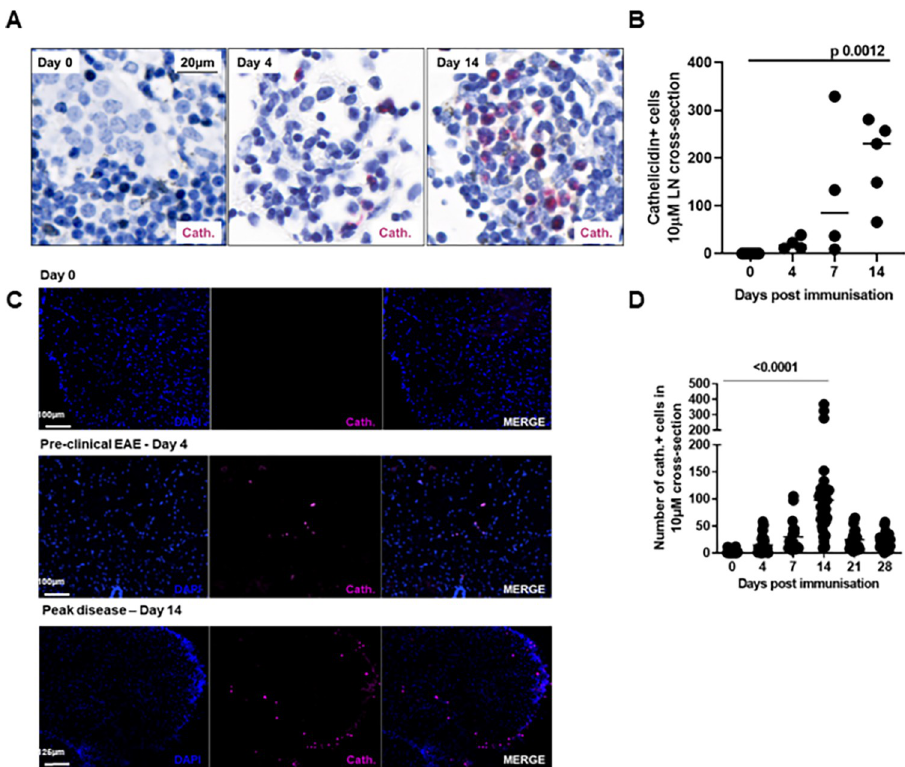
Fig 1. The antimicrobial peptide cathelicidin is produced in the CNS during EAE. EAE was induced in WT C57BL/ 6J mice on day 0 and mice observed for 28 days. Throughout the experiment, mice were humanely culled, perfused with 4% paraformaldehyde and cathelicidin-producing cells were quantified in (A, B) draining inguinal lymph nodes and (C, D) spinal cords. Statistical tests used: B—one-way ANOVA, D–two-tailed t test comparing day 14 to day 0. N values: A–images representative of 5–8 sections from 3 mice; B—3–5 sections from 3 mice; C–images representative of 3–4 mice; D– 13–42 sections analysed from 4–6 mice. Data available at 10.6084/m9.figshare.20310363. Cath, cathelicidin; CNS, central nervous system; EAE, experimental autoimmune encephalomyelitis; LN, lymph node; WT, wild-type.